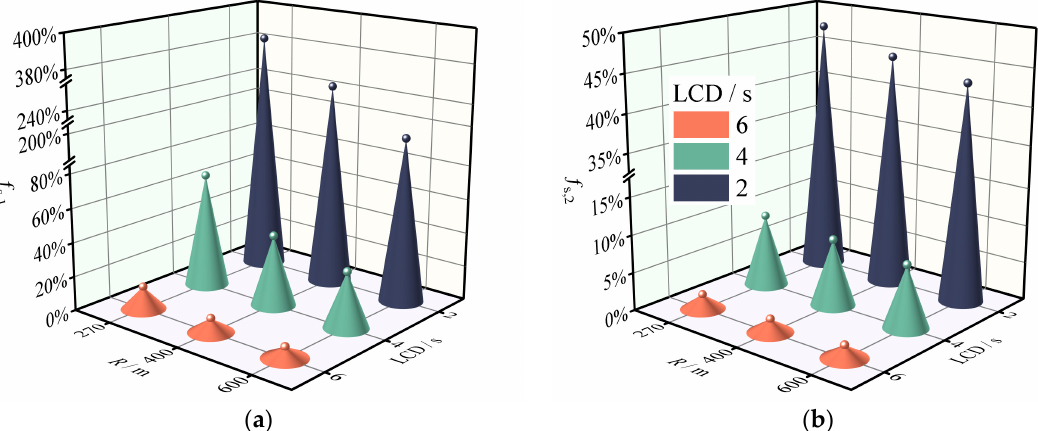
Figure 8. Safety margin reduction rate of the SUV on the horizontal curve and grade combinations under LC_A. ( a ) Sideslip margin reduction rate. ( b ) Rollover margin reduction rate.